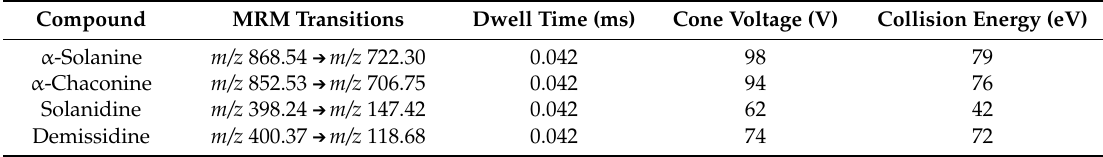
Table 2. MRM parameters for UHPLC-MS/MS data acquisition of steroidal alkaloids of potato peel